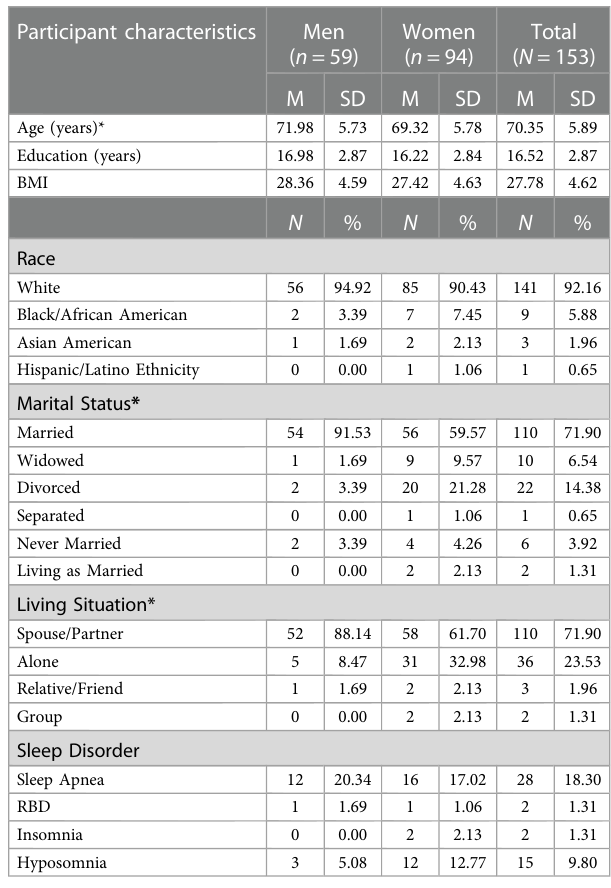
12:48:26. See Figure 1 for a visual representation of activity patterns across the 24-hour cycle for all participants.